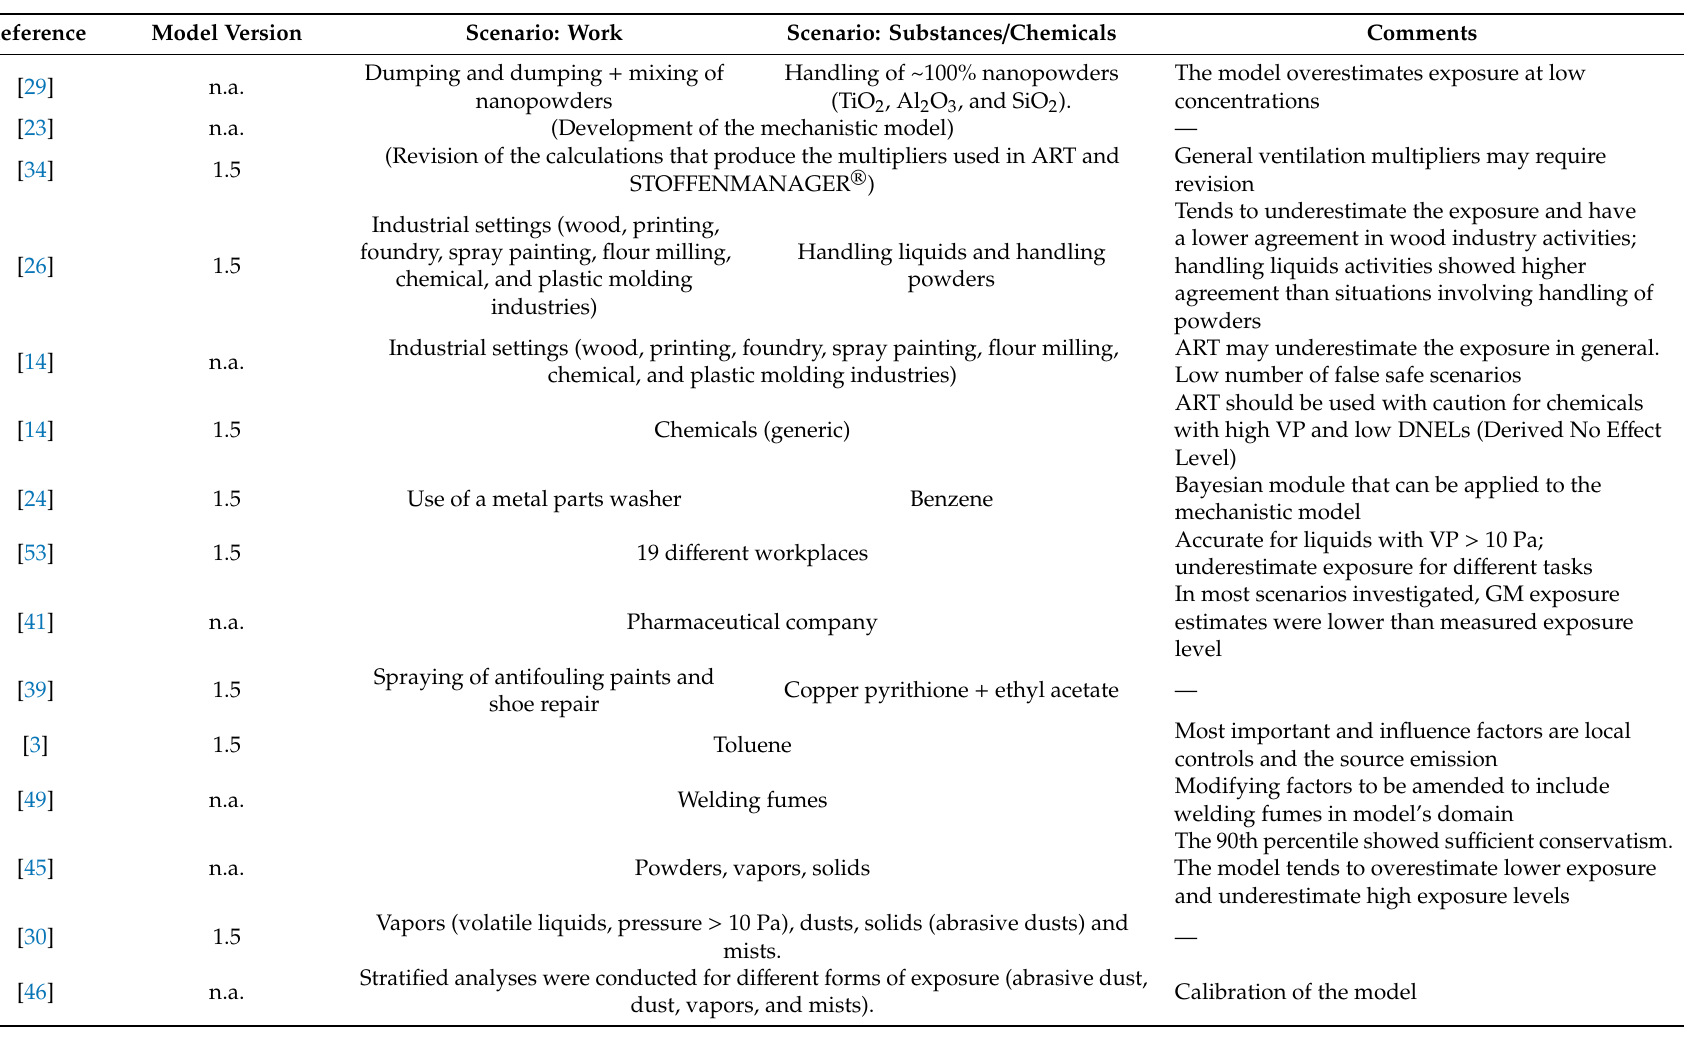
Table 10. Summary of articles found in the present review concerning the ART